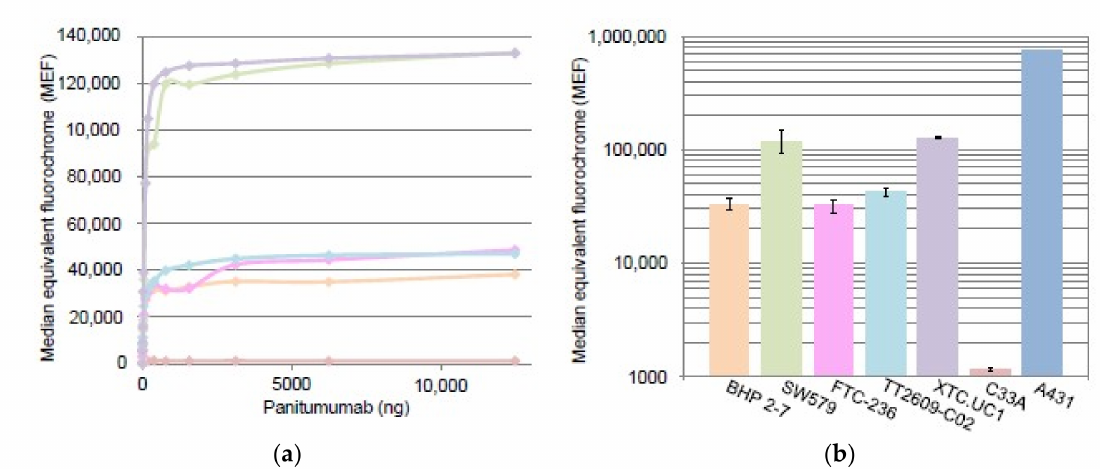
Figure 4. EGFR quantification of thyroid cancer cell lines by flow cytometry. ( a ) Represented by the purple line XTC.UC1 and the green line SW579. These show a relatively higher MEF as compared to the other thyroid cancer cell lines: TT2609-C02 (aqua line), FTC-236 (pink line), and BHP2-7 (orange line). Negative control: C33A (light red line). ( b ) Corresponding bar chart, including EGFR overexpressing A431 cells (dark blue bar) as a